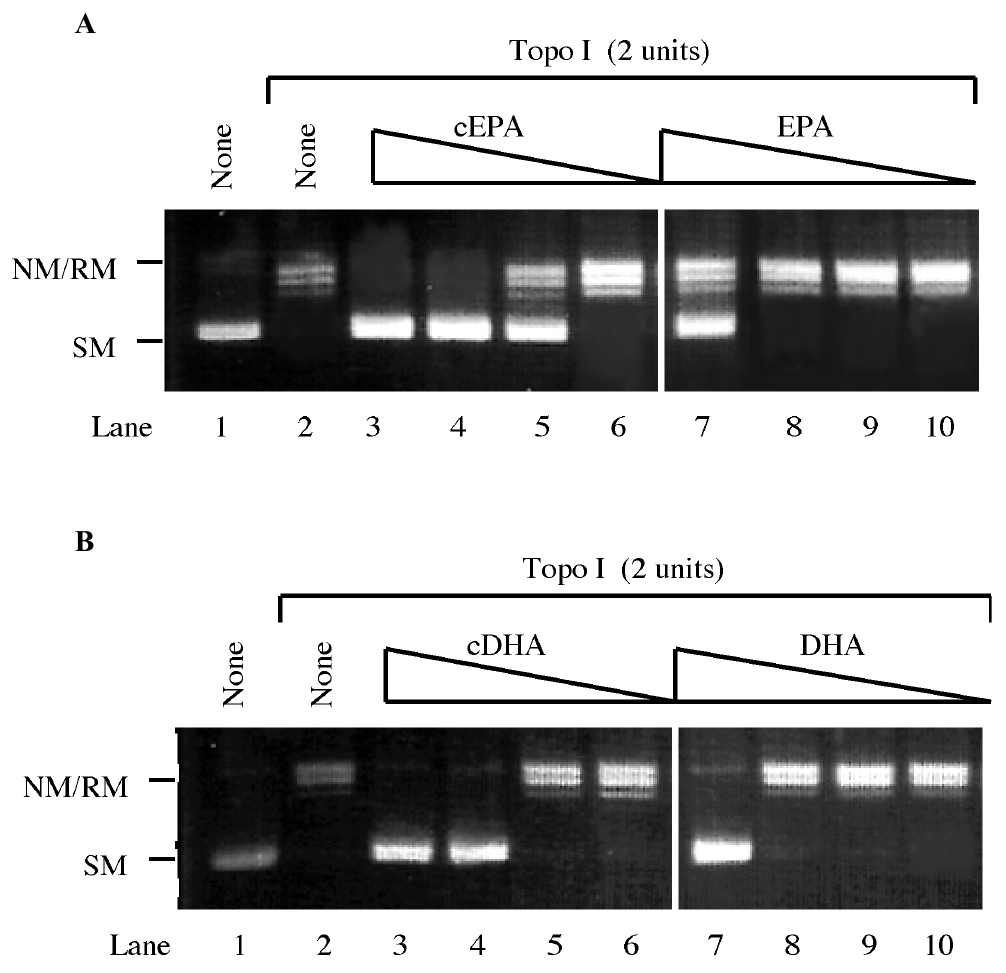
Figure 2. Inhibition of catalytic activity (i.e., nicking activity) of human topo I by normal and conjugated PUFA. (A) EPA and cEPA, (B) DHA and cDHA. Lane 1, supercoiled pBR322 DNA; lanes 2-10, DNA with 2 units of human topo I; lanes 3-6, inhibition of catalytic activity in the presence of 25, 5, 1 or 0.2 μ M cEPA/cDHA; lanes 7-10, inhibition of catalytic activity in the presence of 25, 5, 1 or 0.2 μ M EPA/DHA. Positions of the supercoiled monomer (SM), nicked monomer (NM) and relaxed monomer (RM) are